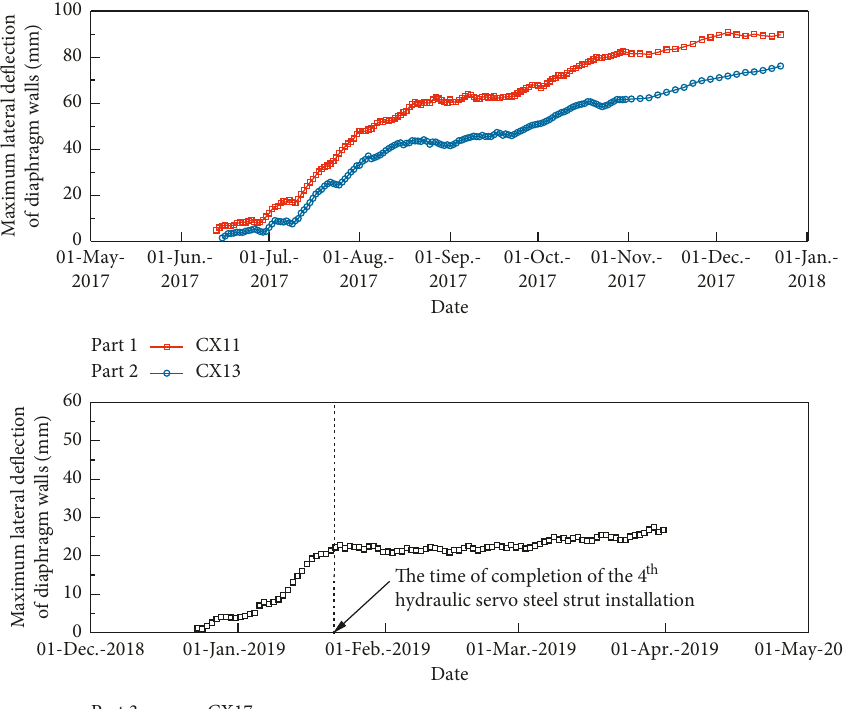
Figure 9: Curve of the maximum lateral deflection of the diaphragm wall with respect to time.